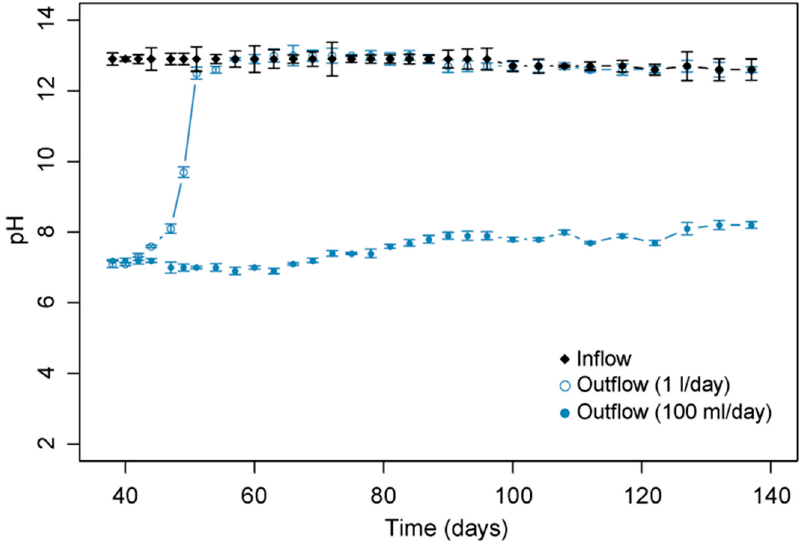
Figure 2. pH variations in reactors that were inoculated with alkaline influent waters—dissolution group S1—and were operated continuously for 14 weeks after 37 days of batch operation.